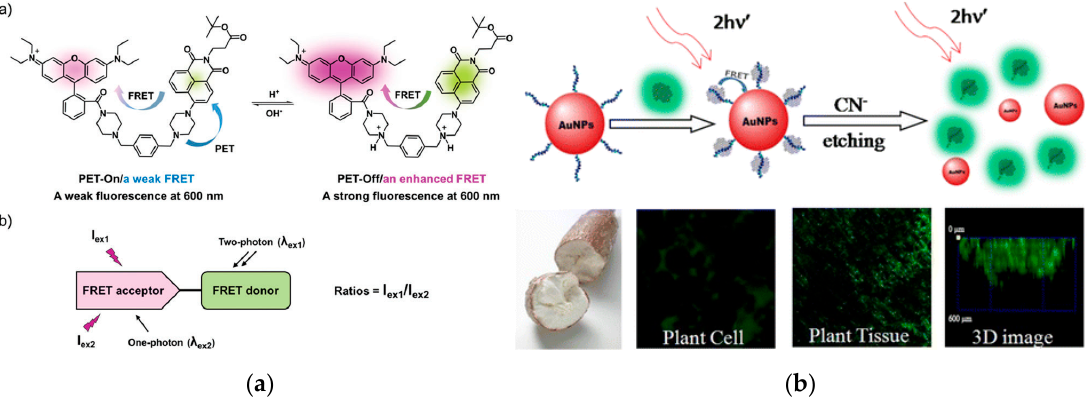
Figure 9. Two-photon fluorescence excitation based on metal NPs. ( a ) High-depth fluorescence imaging using a two-photon FRET system for mitochondrial pH. Reproduced with permission